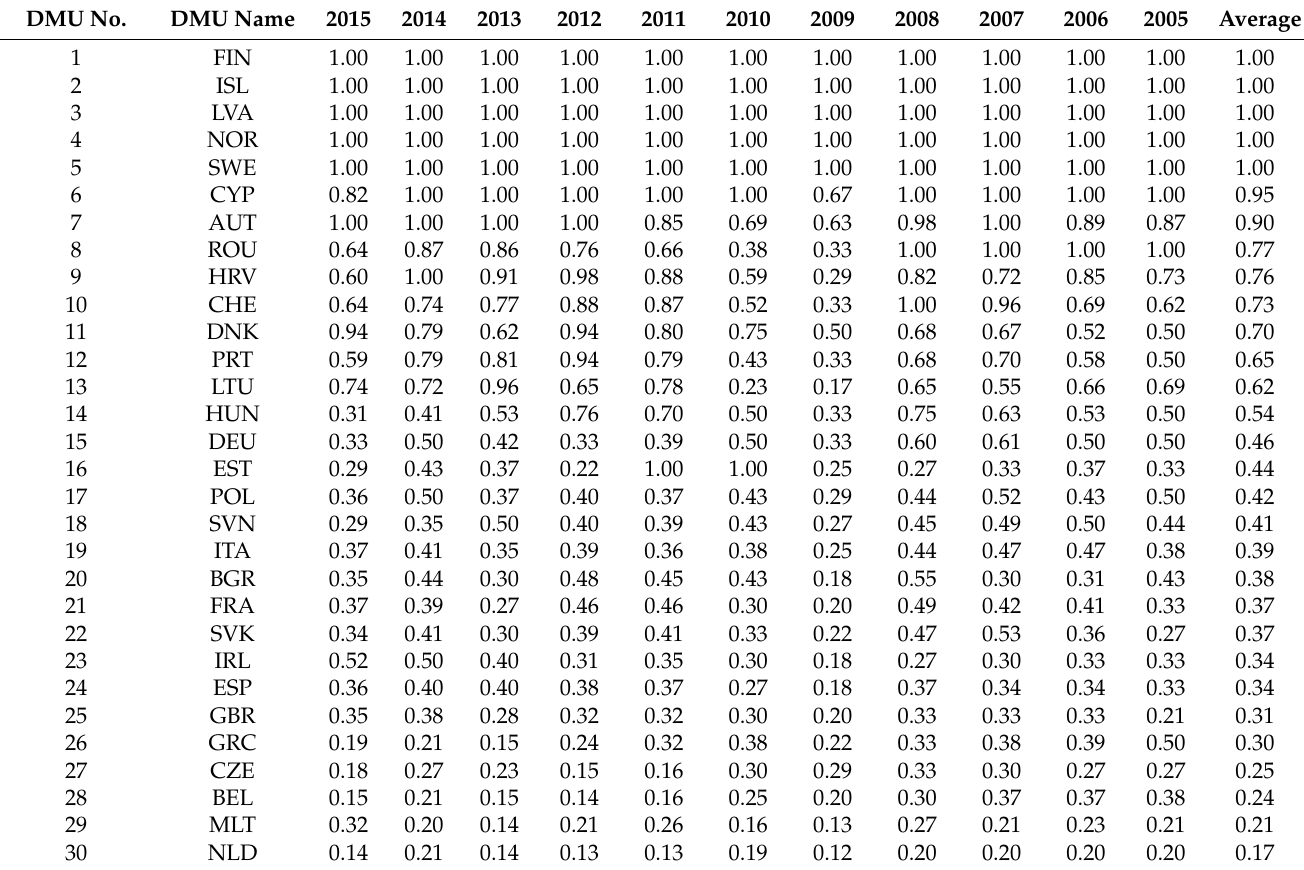
Table 6. Input-Oriented VRS Efficiency of Environmental Protection Expenditure in 2005–2015. Source: Authors’ calculations in